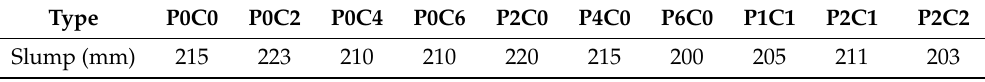
Table 5. The work ability of high-strength concretes.